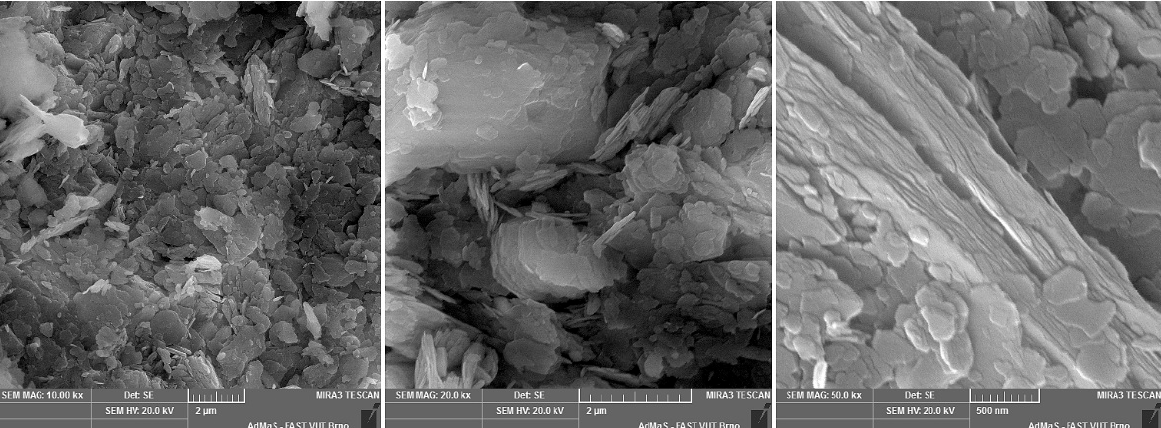
Figure A1. W-super claystone.